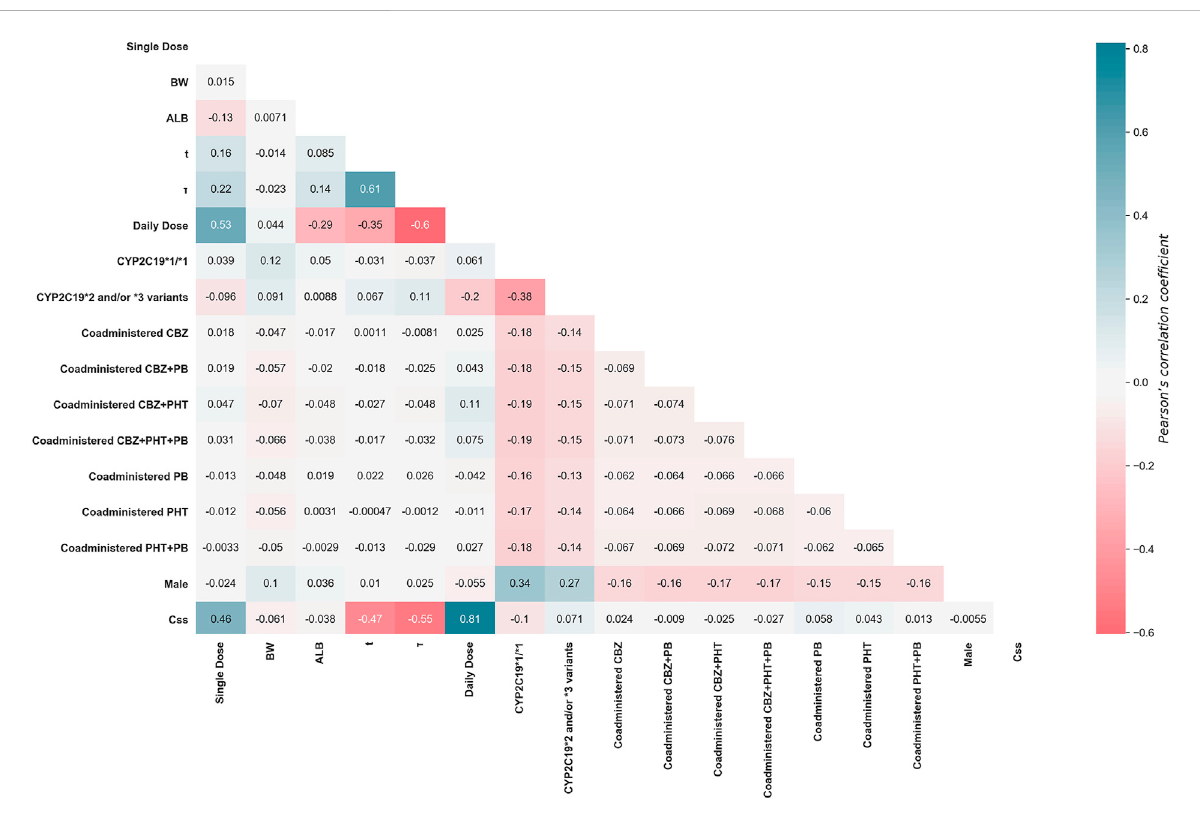
FIGURE 3 Heat map of Pearson ’ s correlations between C ss of VPA and